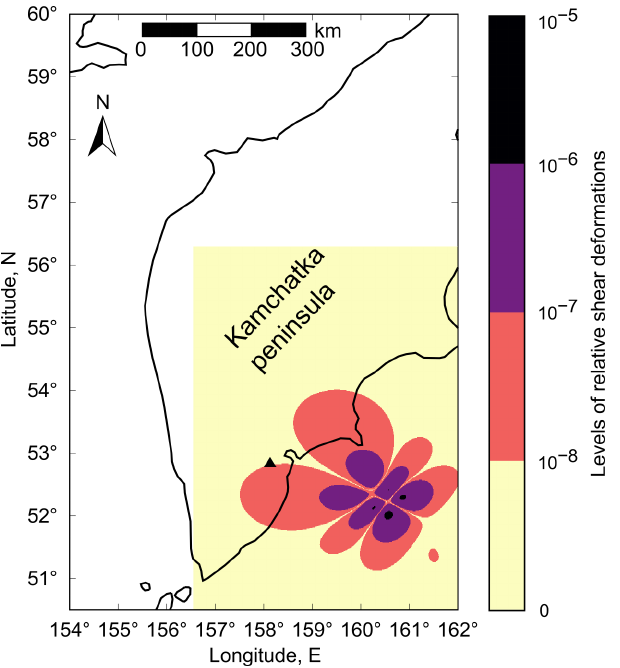
Figure 5. Zones of relative shear deformations on the Earth’s surface z = 0 simulated for earth- quake No. 1. The triangle on the map indicates the location of the Karymshina observation